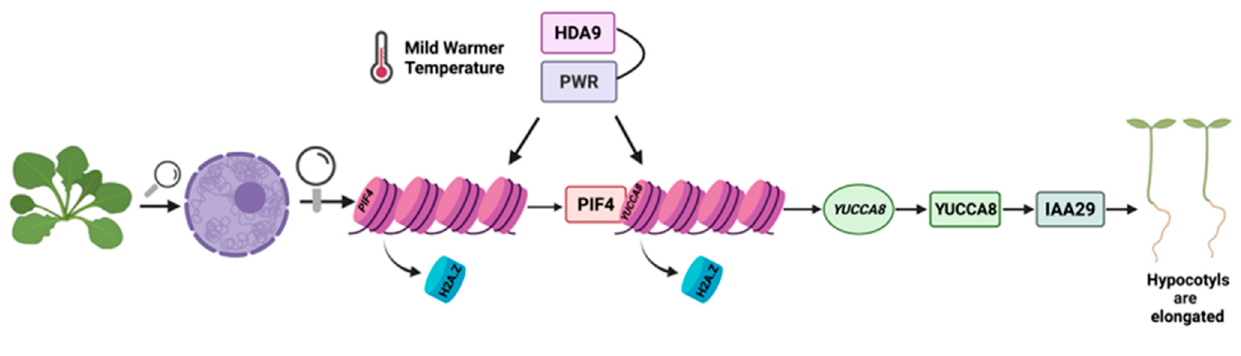
Figure 1. The epigenetic events underlying warmer average temperature responses. Under mild warmer average temperatures hypocotyl elongation is induced through the action of different factors. POWERDRESS (PWR) and HISTONE DEACETYLASE 9 (HDA9) physically interact, resulting in histone deacetylation of specific loci. This event is important for the subsequent exclusion of H2A.Z from +1 nucleosomes of PIF4 and YUCCA8 . PWR acts upstream of the hypocotyl elongation factor PIF4 as a chromatin remodeler facilitating this process. The above events result in the ability of PIF4 to bind the YUCCA8 promoter. YUCCA8 protein synthesis in turn leads to the expression of further auxin-regulating genes such as IAA29 , which further leads to IAA29 protein synthesis and subsequent hypocotyl elongation. Proteins are depicted in squares and genes in circles. The figure was created in BioRender.